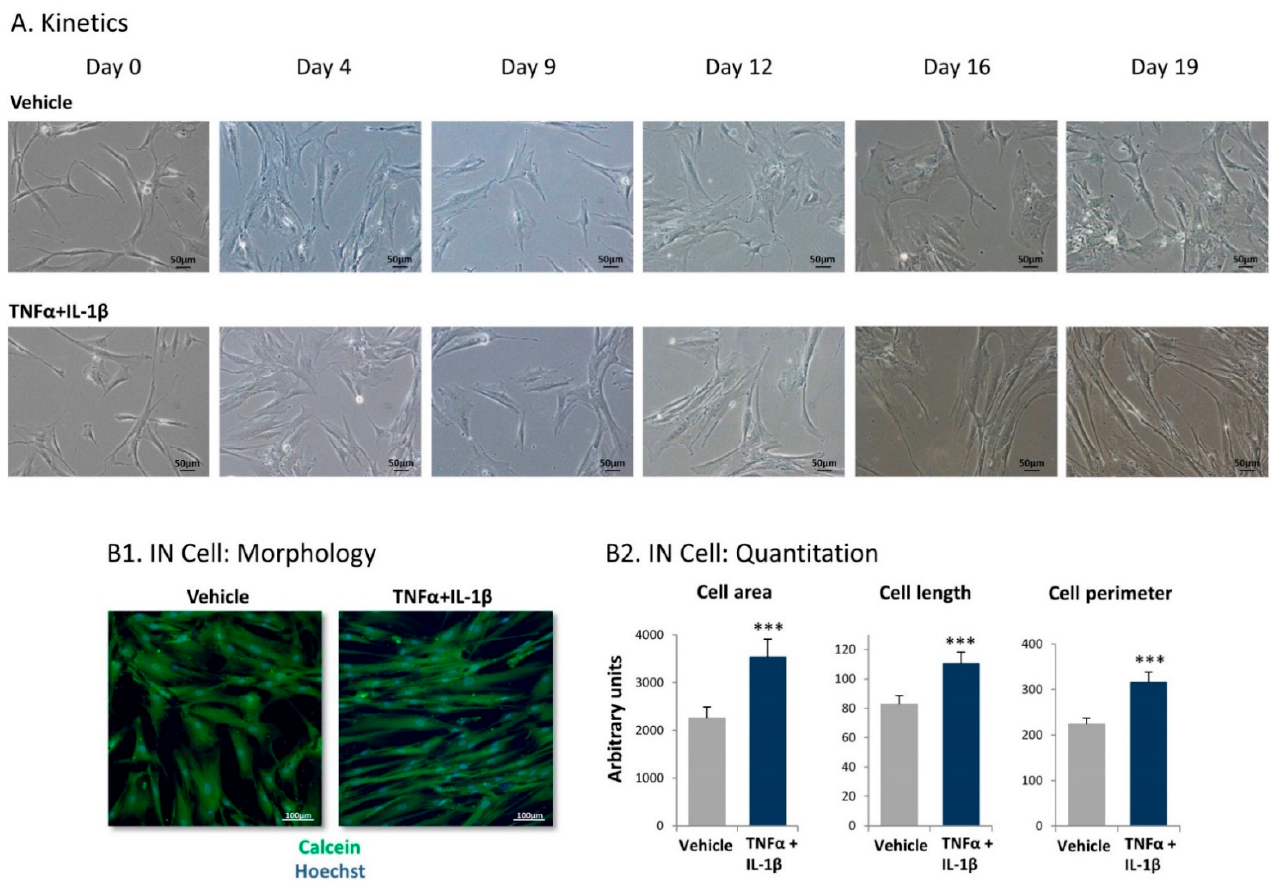
Figure 1. Following persistent stimulation of mesenchymal stem cells (MSCs) by tumor necrosis factor α (TNF α ) + interleukin 1 β (IL-1 β ), the resulting cells acquire elongated cancer-associated fibroblast (CAF)-like morphology. Human MSCs were exposed to TNF α (50 ng/mL) + IL-1 β (0.5 ng/mL) or to vehicles. Cytokine concentrations were selected based on the considerations described in the Materials and Methods section. ( A ) At different time points, the cells were photographed by light microscopy. Images from a representative experiment out of n > 3 are presented. Bar, 50 μ m. ( B ) Determination of cell characteristics using IN Cell technology in cells that were treated using the cytokines/vehicles for 18 days and were then subjected to IN Cell analysis. ( B1 ) Cell morphology was detected by calcein (green) and Hoechst (blue) staining. Images of cell morphology from a representative experiment out of n = 3 are presented. Bar, 100 μ m. ( B2 ) Quantification of cell characteristics by the IN Cell technology. *** p < 0.001. The results of a representative experiment of n = 3 are presented.